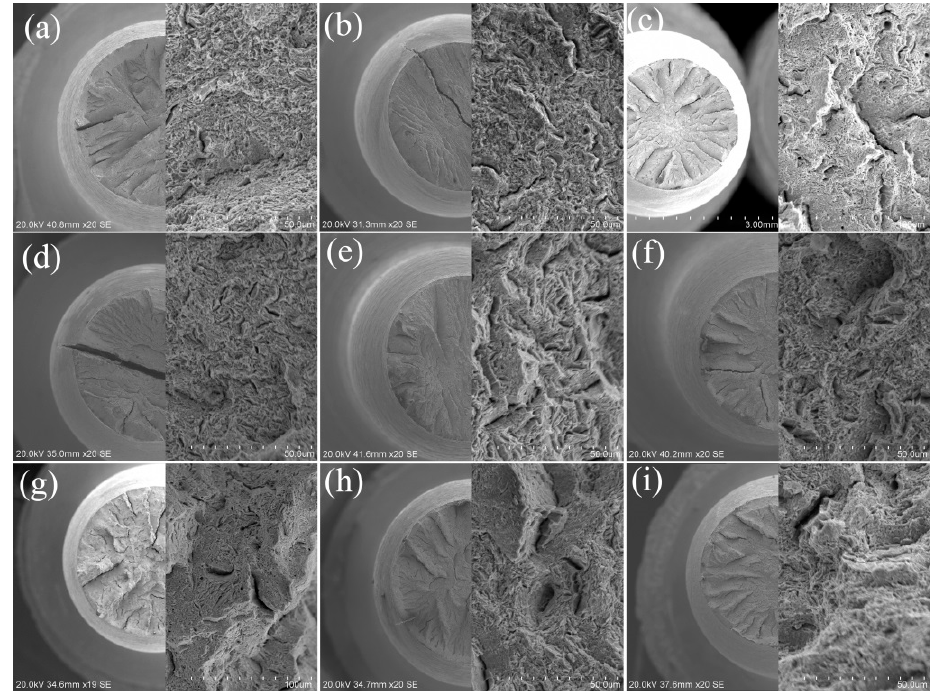
Figure 12. Tensile fractographies of 15Cr12MoVWN steel at room temperature under conditions of ( a ) 0W, ( b ) 0O, ( c ) 0A, ( d ) 5O, ( e ) 5A, ( f ) 5W, ( g ) 8A, ( h ) 8W, ( i ) 8O.